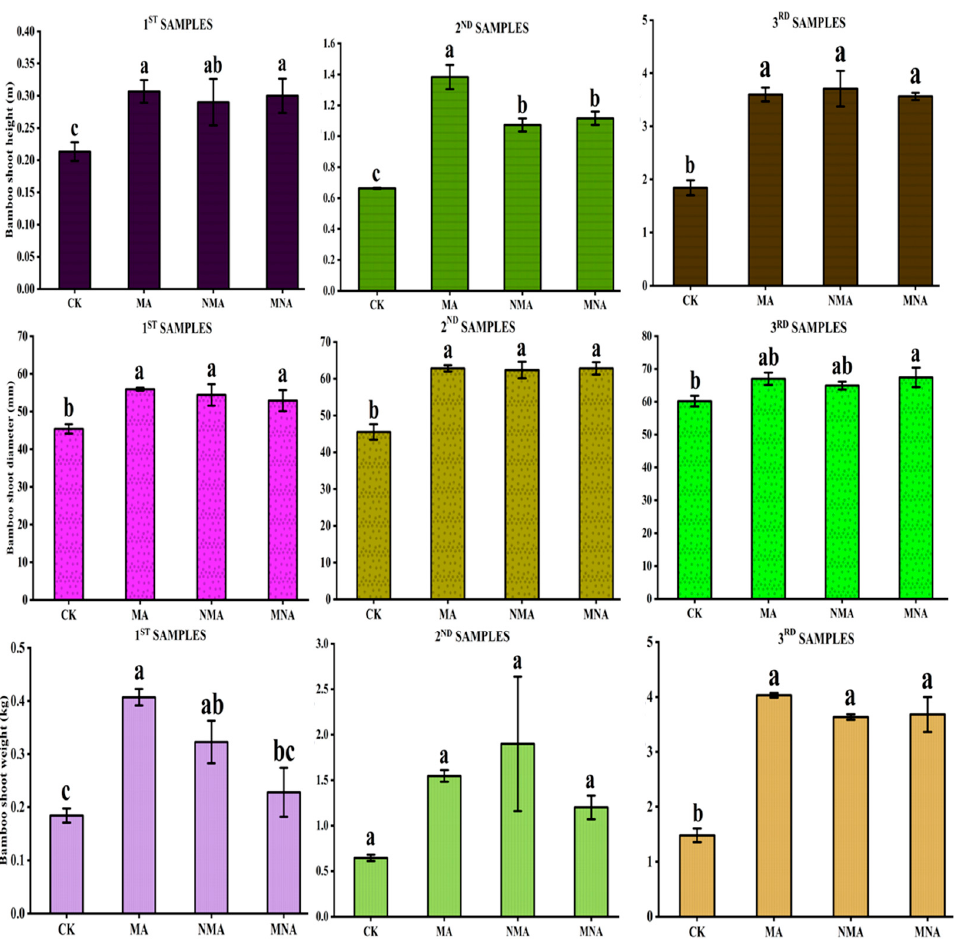
Figure 9. Effects of different treatments on shoot height ( top row ), shoot diameter ( middle row ) and shoot weight ( bottom row ). The bars are the standard error of the replications while the different letters on the bars indicate significant differences at p < 0.05. 1st, 2nd, and 3rd sampling indicate sampling results of the first, second and fourth week of November 2021.